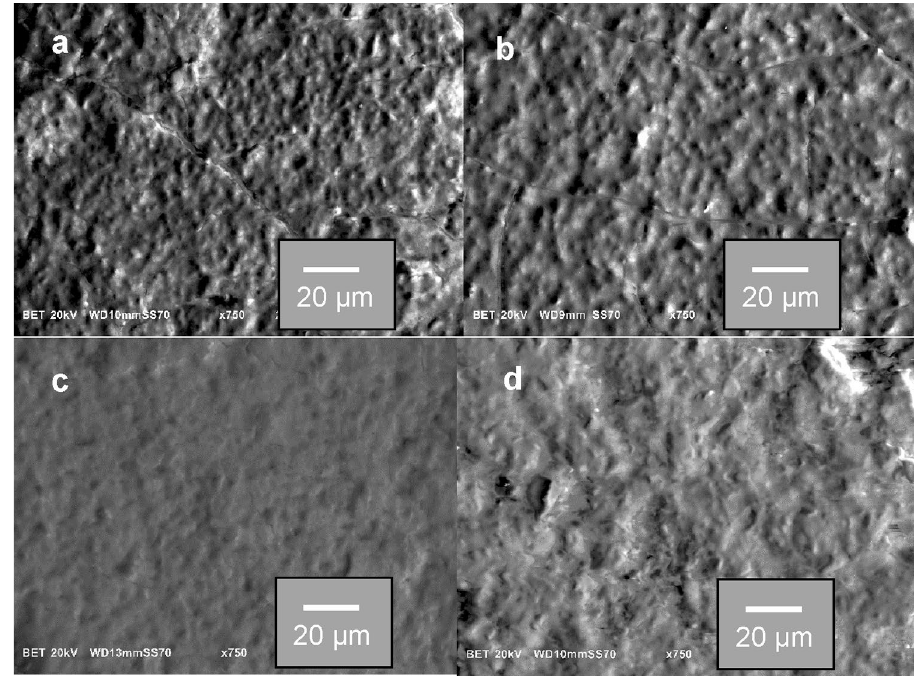
Figure 1. Microphotographs of glass-ionomer cements samples: ( a ) GIC and ( b ) GIC-BPE, before immersion in SBF solution; and ( c ) GIC and ( d ) GIC-BPE, after immersion in SBF solution for 96